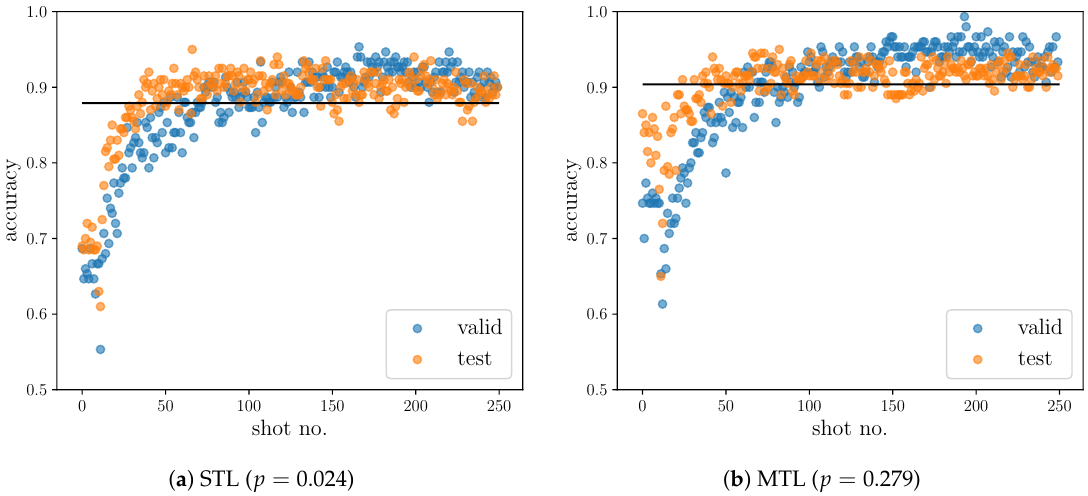
Figure 4. The comparison of ACC of Power Classification over each shot no. between ( a ) STL and ( b ) MTL is significantly different ( p < 0.001). The black lines denote the ACC over the validation and test sets.